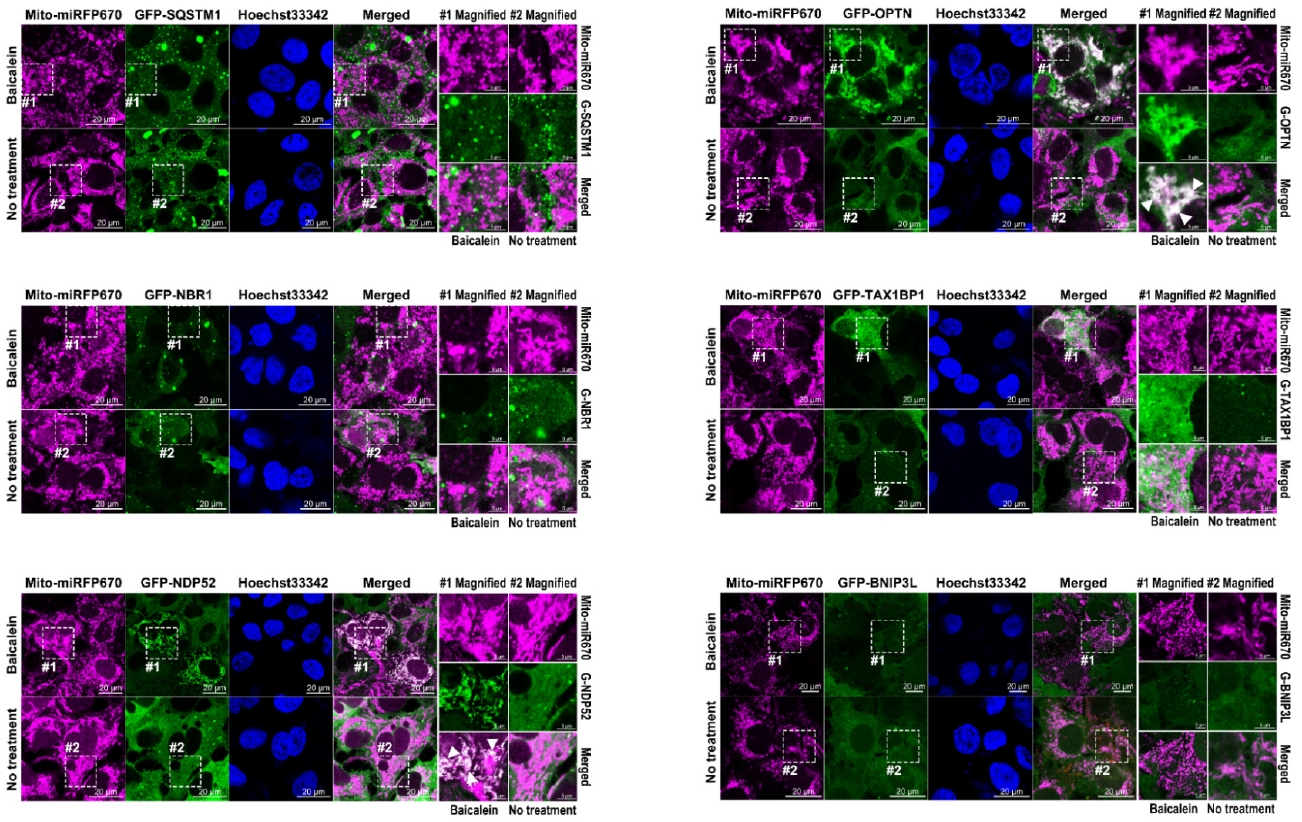
Figure 11. Assessment of the translocation of cargo receptors to mitochondria in baicalein-treated cells. Huh7/Mito-miRFP670/GFP-SQSTM1, Huh7/Mito-miRFP670/GFP-NBR1, Huh7/Mito-miRFP670/GFP-NDP52, Huh7/Mito-miRFP670/GFP-OPTN, Huh7/Mito-miRFP670/GFP-TAX1BP1, and Huh7/Mito-miRFP670/GFP-BNIP3L cells established by lentiviral gene delivery were cultured in the presence or absence of 0.5 mM baicalein for four hours. Then, the cells were fixed, stained with Hoechst 33342, and analyzed by confocal microscopy. Magnified field-1 and magnified field-2, respectively, show enlarged images of the areas in white dashed boxes 1 and 2 in the images of baicalein-treated and untreated cells in each panel. The white arrowheads in magnified field-1 indicate the overlapping signal.